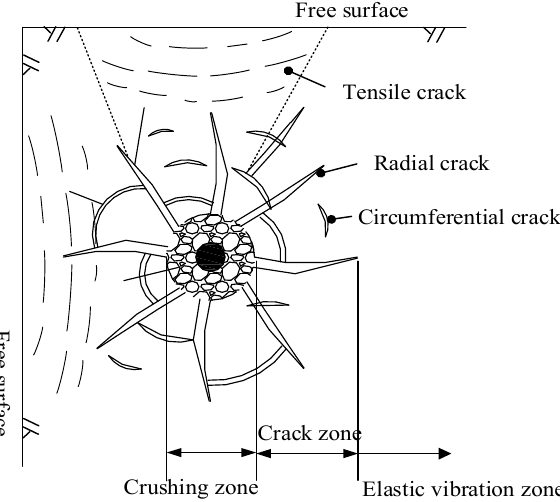
Figure 1. Blasting plane diagram.